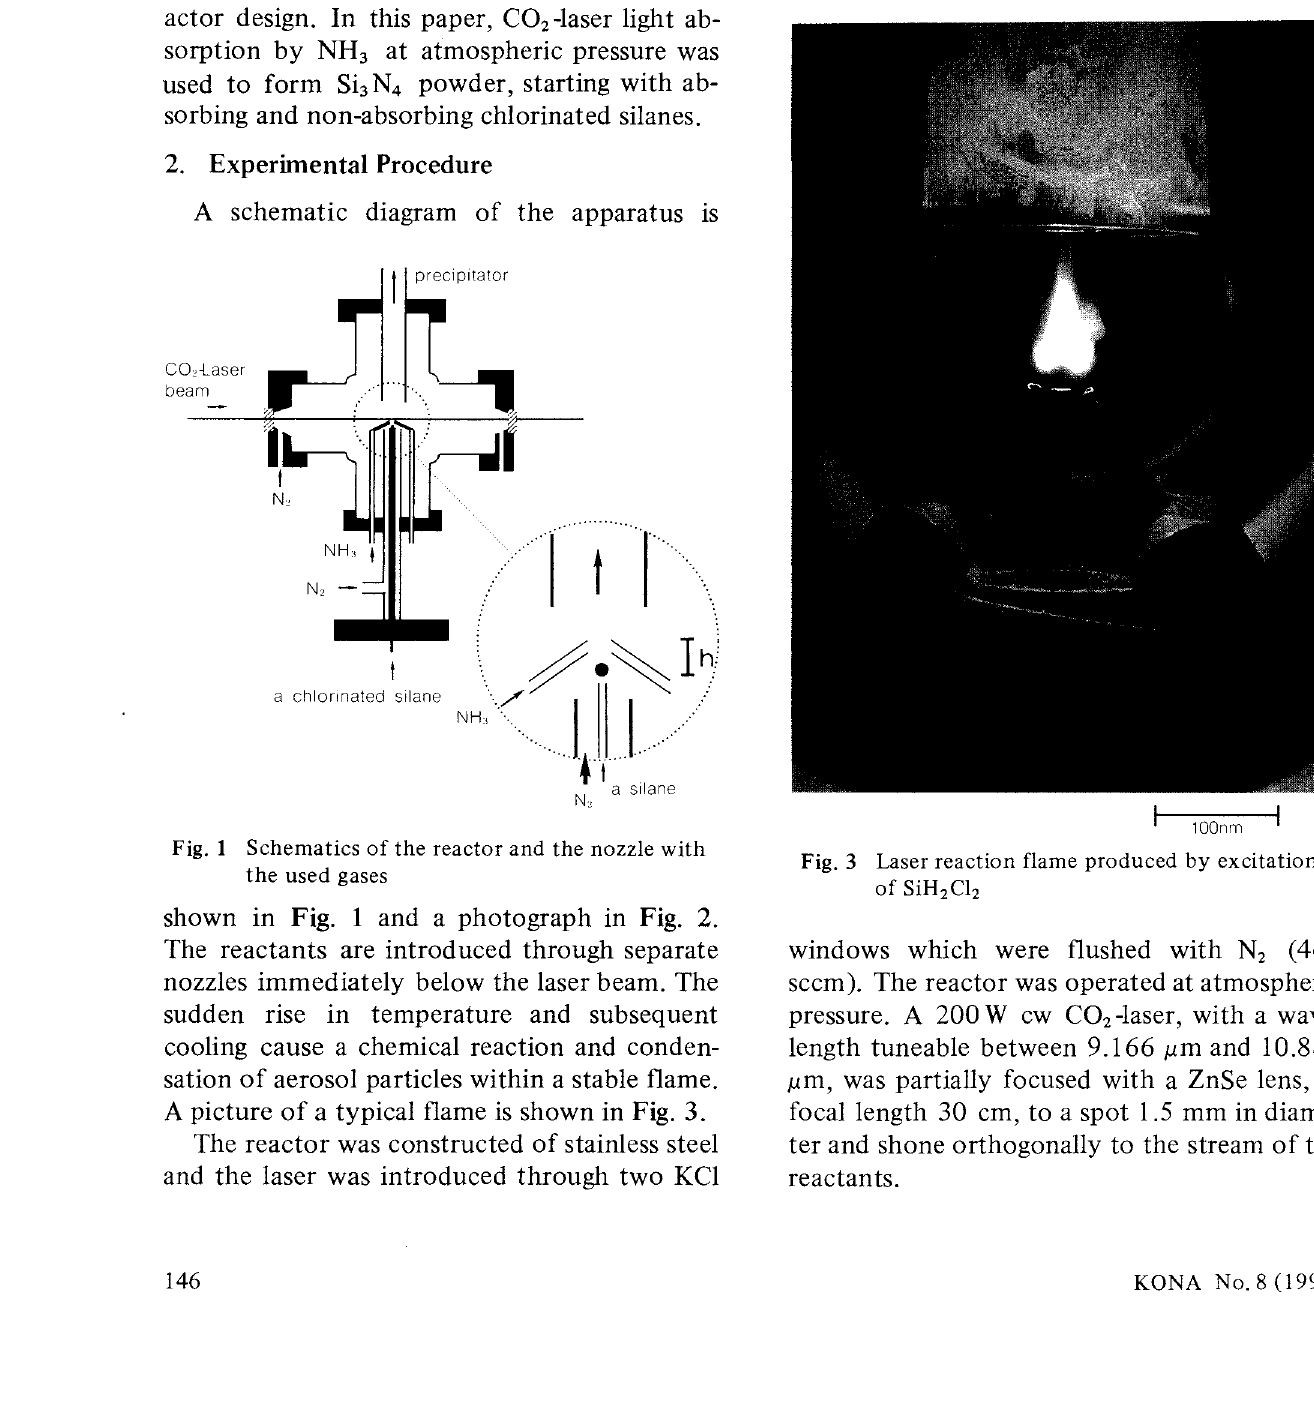
Fig. 2 Photograph of the laser reactor